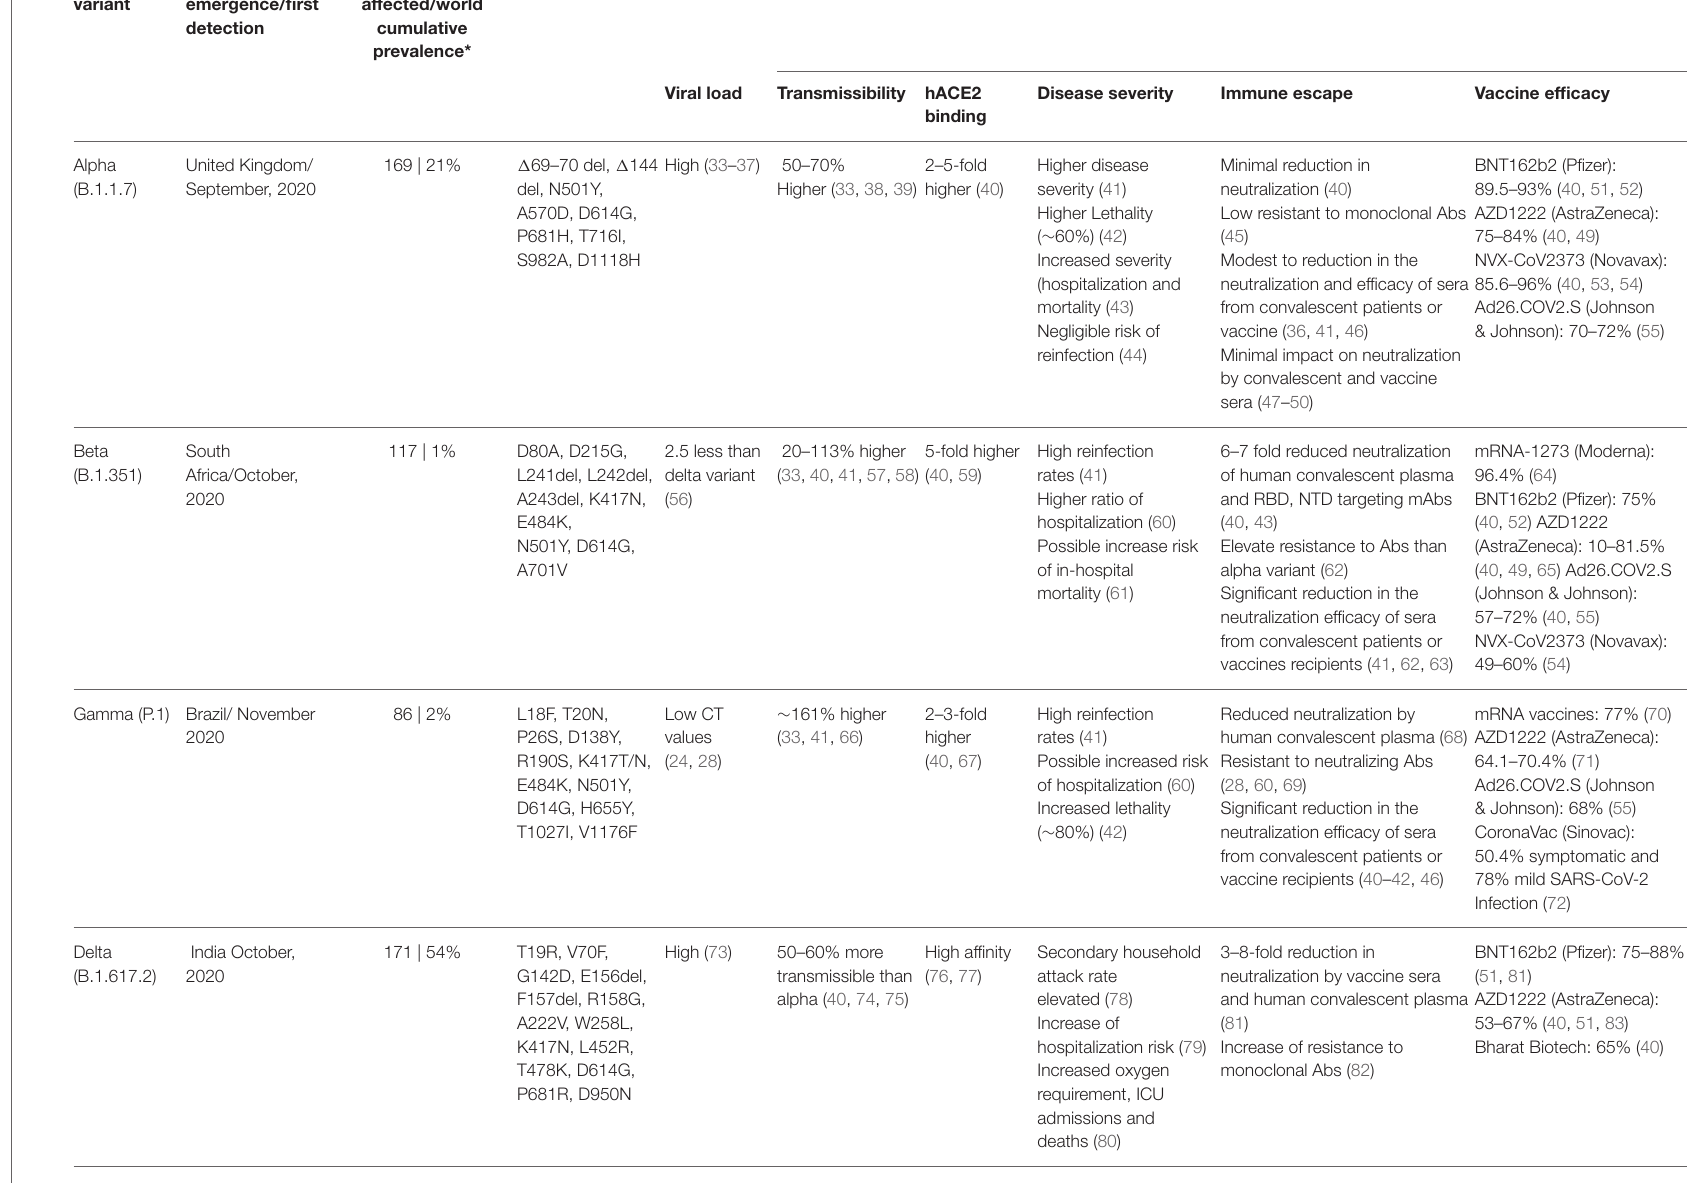
TABLE 1 | Characterization of SARS-CoV-2 variants of